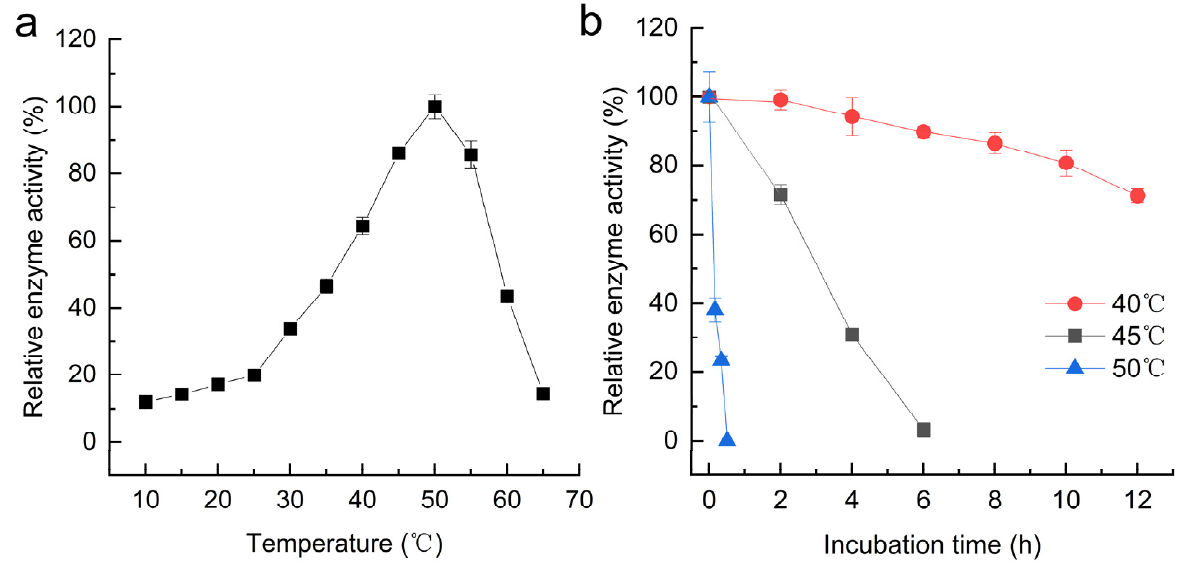
Figure 6. Effects of temperature on MpTre15A activity ( a ), and thermo-stability ( b ): ( a ) the activities of MpTre15A were measured at various temperatures (10 to 65 °C) in 100 mM citrate buffer (pH 5.0); ( b ) MpTre15A were incubated at various temperatures (40, 45, and 50 °C) for 60 min, and the remaining activities of MpTre15A were measured at 50 °C in 100 mM citrate buffer (pH 5.0). The initial activities without heat treatment were set as 100% with a specific activity of 62.5 U/mg. Ex- periments were performed in triplicate, and the average values are shown.